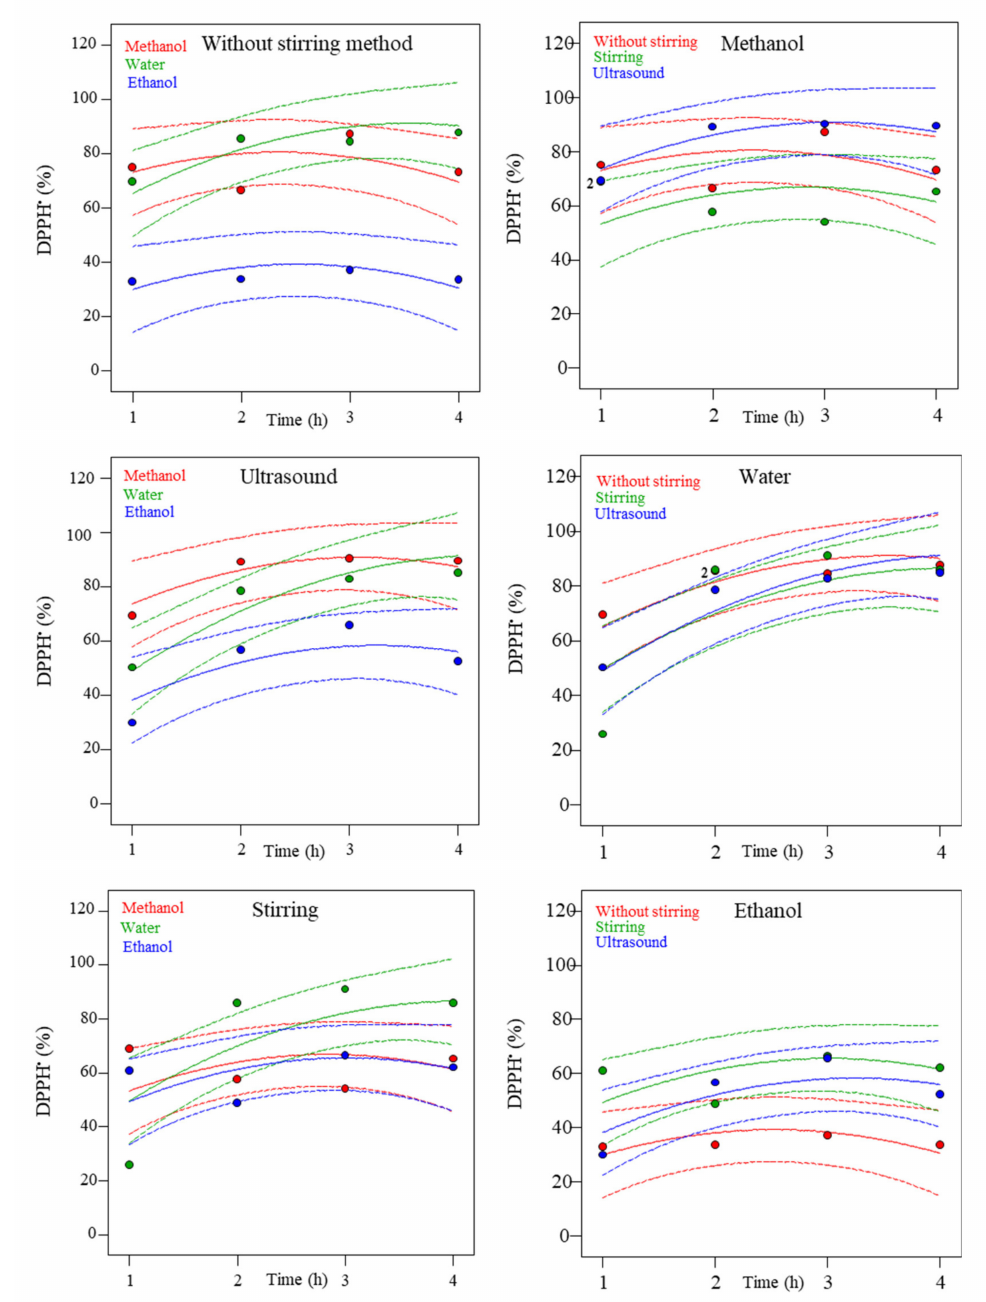
Figure 3. Experimental and predicted dependence of DPPH • (1,1-Diphenyl-2-picrylhydrazyl) assay on time at different methods (without stirring, ultrasound, or stirring) and solvents (methanol, water, or ethanol). Dots are experimental results, dotted lines are 95% confidence bands, and solid lines are the predicted